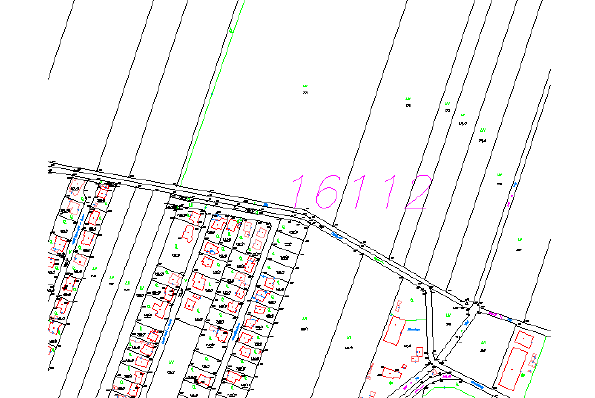
Figure 3. Map sheet 7634-75/1 used for the test (Leopoldseder, 2015, p. 35, data: © BEV) The selected map sheet was adapted using the shape from Figure 2 (d). The shape was defined as a new line type in AutoCAD and used to plot the map sheet. Figure 4 shows an example for the first attempt. All lines in the example are originally straight connections between the numbered breakpoints. The new line style was applied to selected lines only (15509 to 15510, 15511 to 7298, 7298 to 6763, starting at 6763) and it clearly visible, which lines were altered and which were not. An advantage of this approach is that the original geometry is not altered and thus the results of computations done on the data set are still correct.